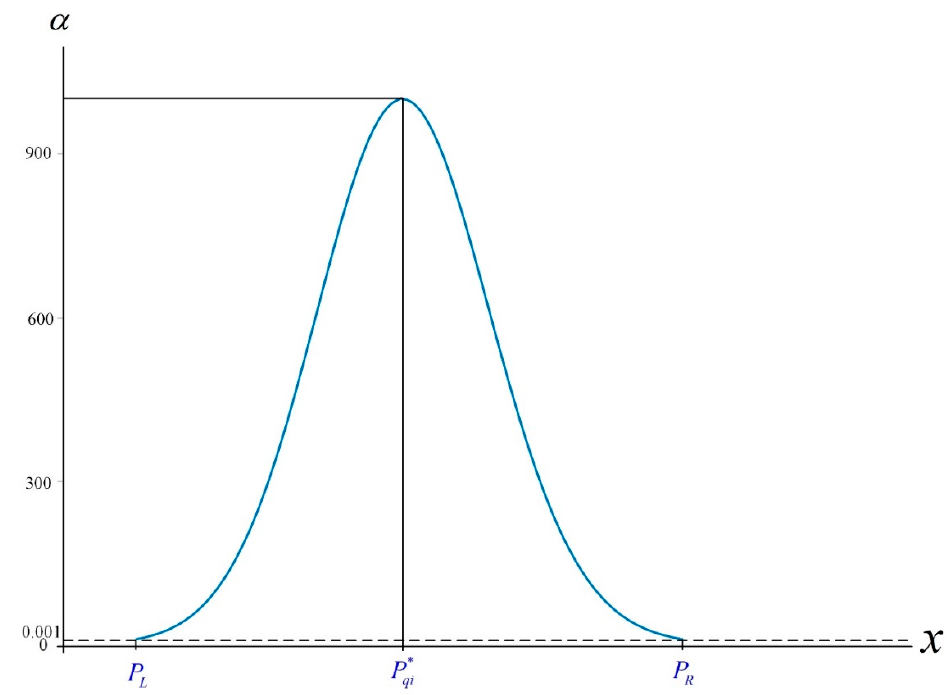
Figure 1. Membership function η ( x